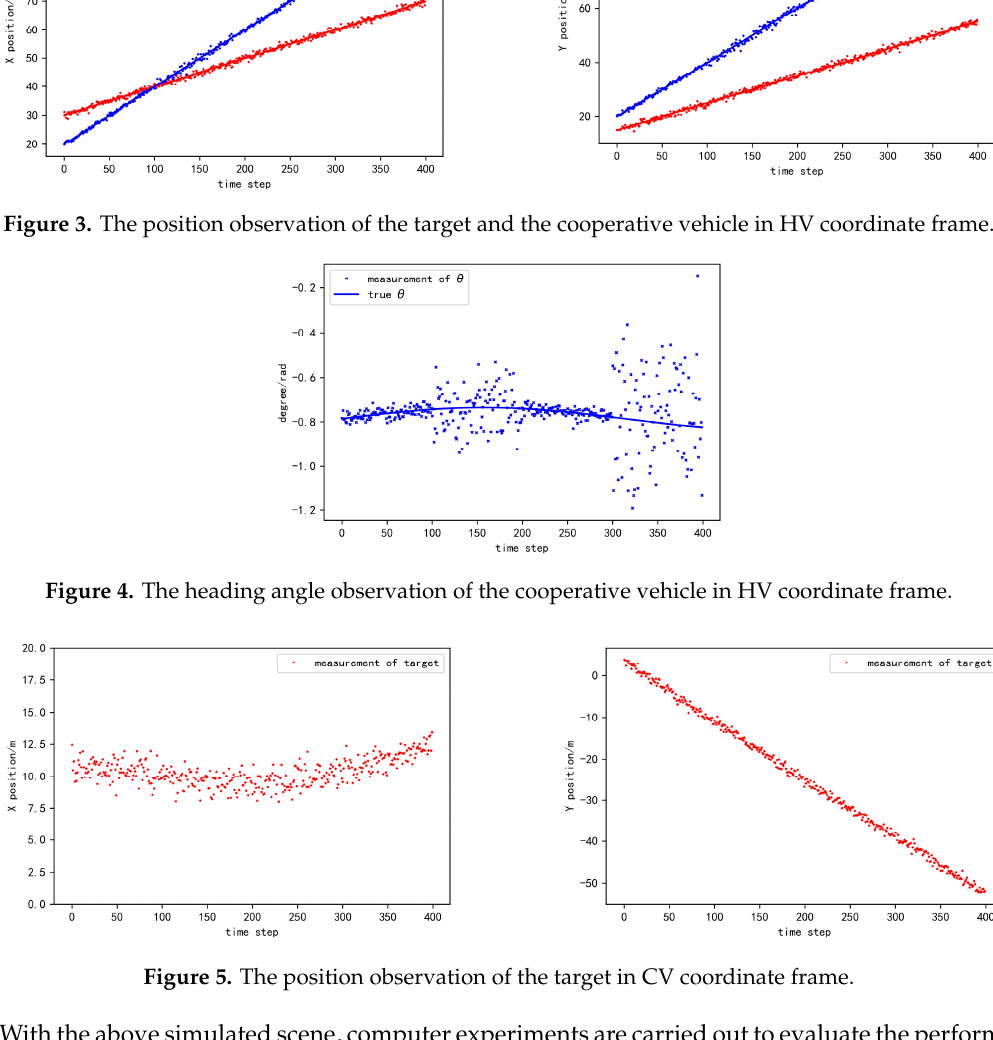
Figure 5. The position observation of the target in CV coordinate frame.